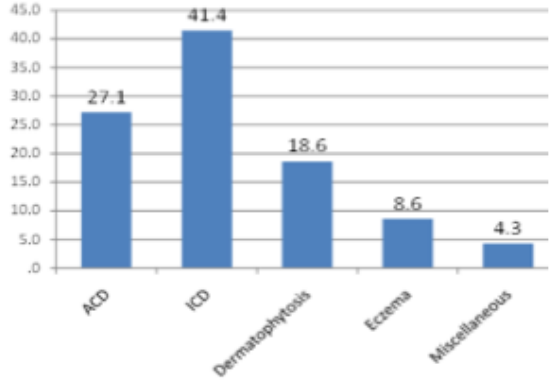
Figure 5: Bar diagram showing different disease conditions and its